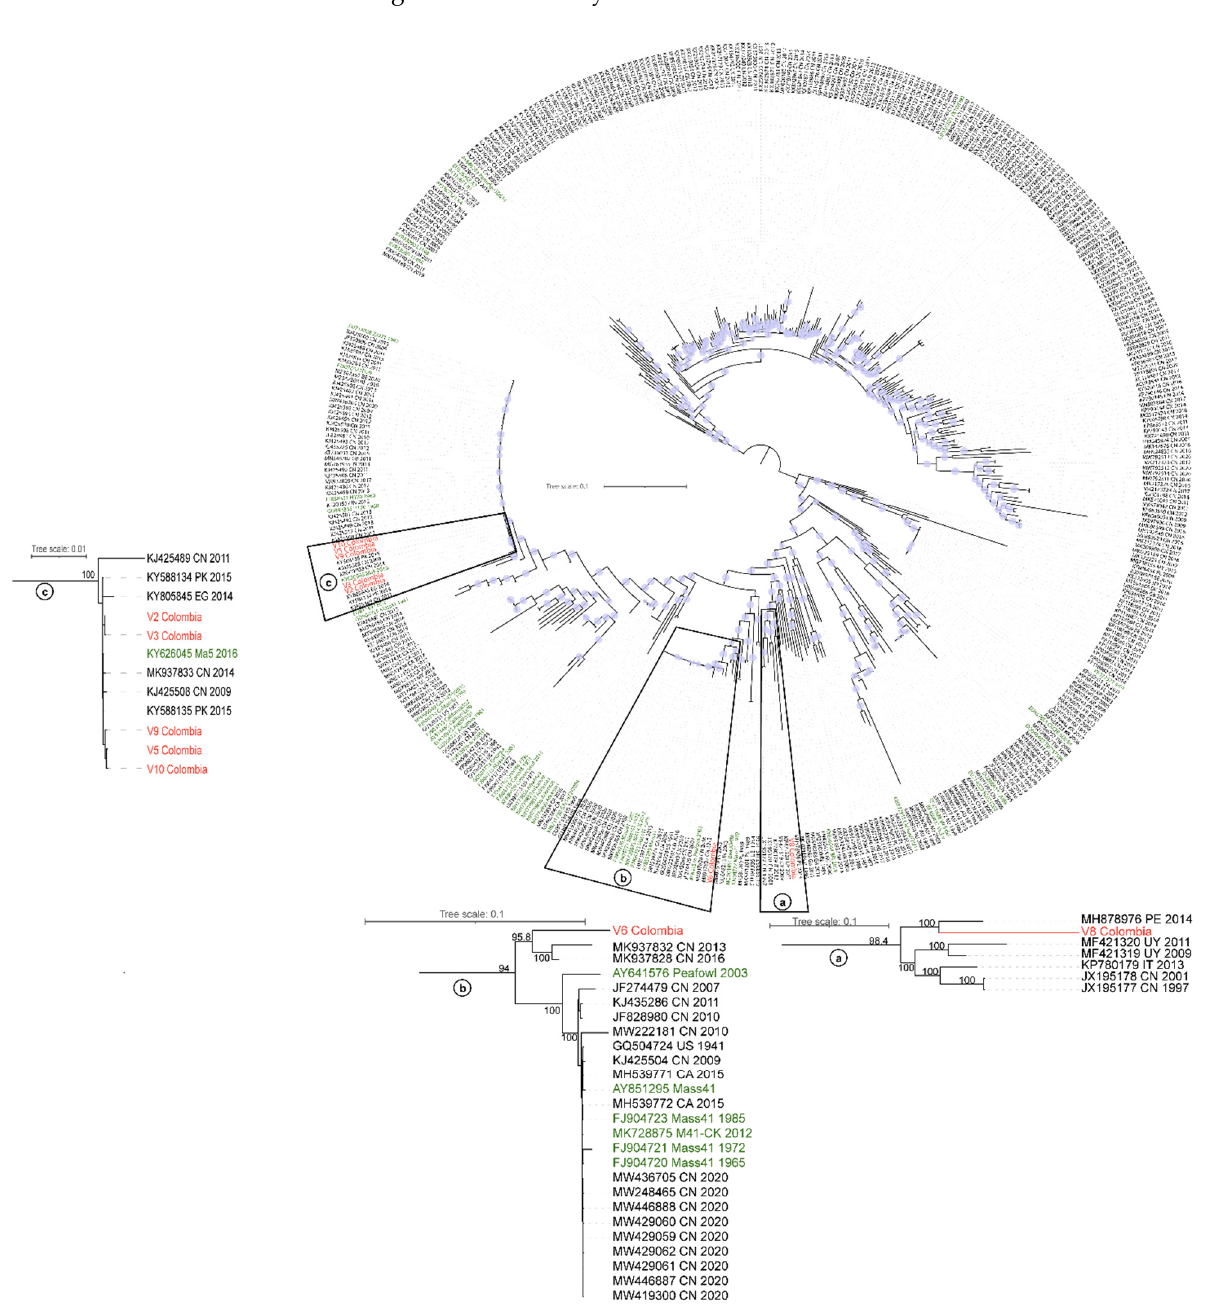
Figure 4. Maximum-likelihood phylogenetic tree of IBV complete genomes ( n = 438). Red labels correspond to IBV Colombian sequences and green labels to vaccine strains. Circles at the nodes denote SH-aLRT branch support values larger than 80%. The tree was midpoint rooted and the lengths of the branches are drawn to scale with the bar at the middle indicating nucleotide substitution per site. Clusters that contain a) V8 b) V6 and c) V2, V3, V5, V9 and V10 Colombian strains are highlighted and magnified. SH-aLRT branch support values are indicated at key nodes and the branch lengths are drawn to scale with the bar at the top indicating nucleotide substitution per site.